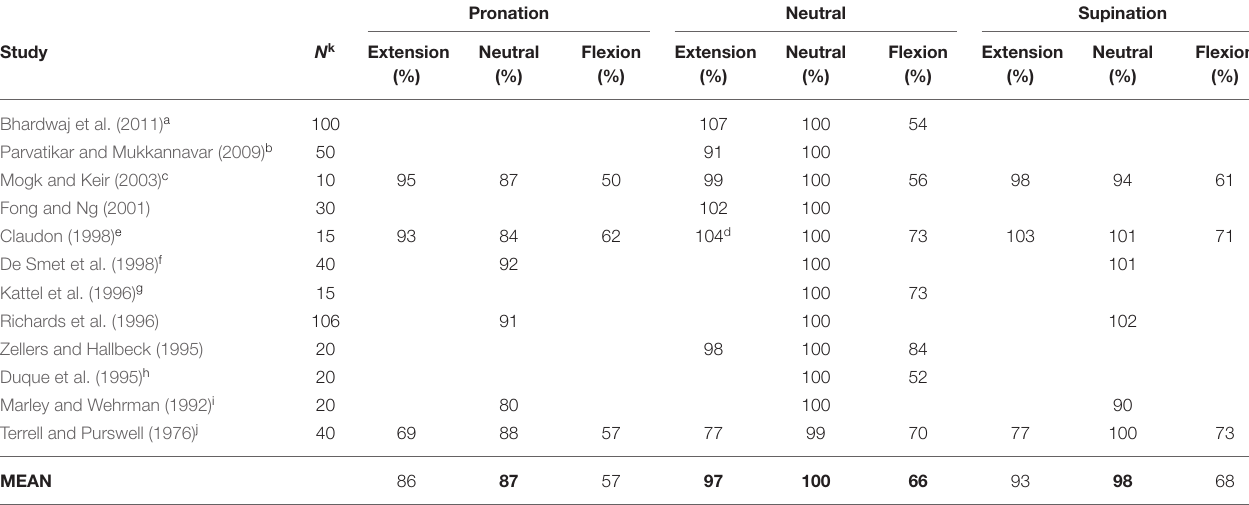
TABLE 1 | Percentage of the maximal grip strength with combined wrist and forearm movements to estimate the thresholds for actions combined with a power grasp. Pronation Neutral Supination Study N k Extension